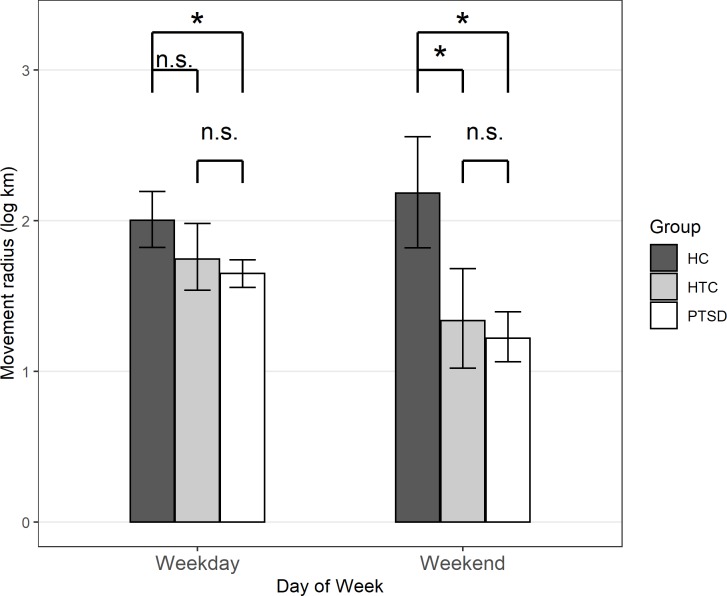
Mean (logarithmized) movement radius on weekdays and weekend days for all groups.Mean (logarithmized) movement radius on weekdays (left) and weekend days (right), separately for the healthy control group (HC; dark grey), the healthy trauma control group (HTC; light grey), and the patient group (PTSD; white). Statistical significance in the figure refers to the results from the main analyses (no covariates): *p < .05, n.s.: p > .05.